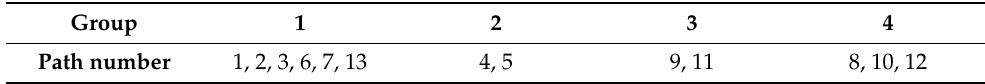
Figure 13. Table 4. Highly related paths when λ = 2 . Group 1 2 3 4 Path